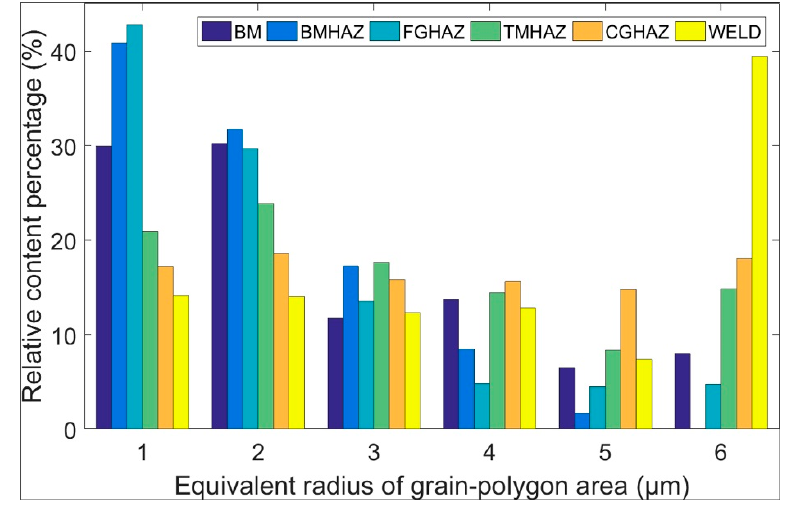
Figure 5. Histogram of the grain size distribution of each zone (from the BM to the WELD) of an X100 laser-welded laser-welded joint.